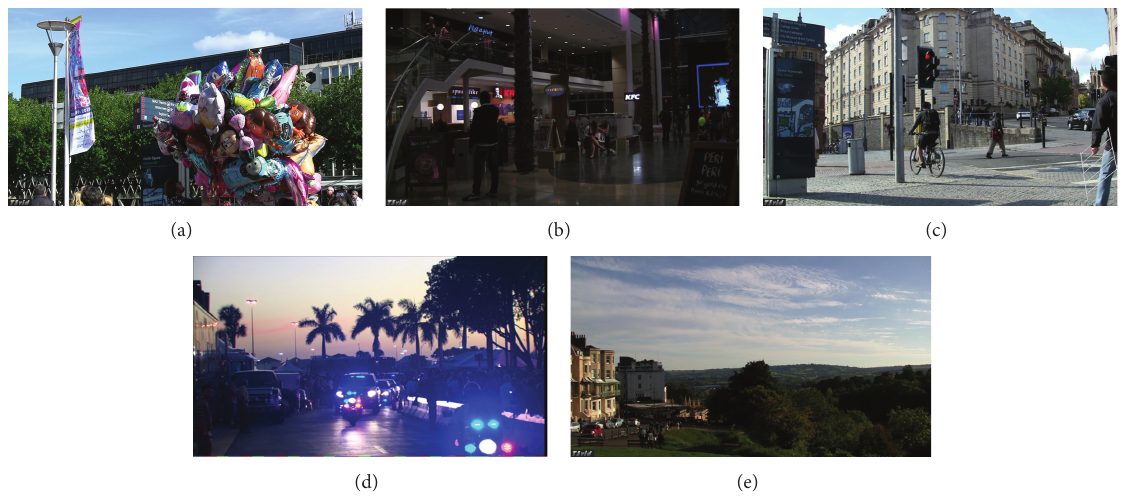
Figure 2: Stimuli used in the experiments: (a) Balloon, (b) Mall, (c) PedXing, and (d) BCS, which was replaced after the first experiment by (e)